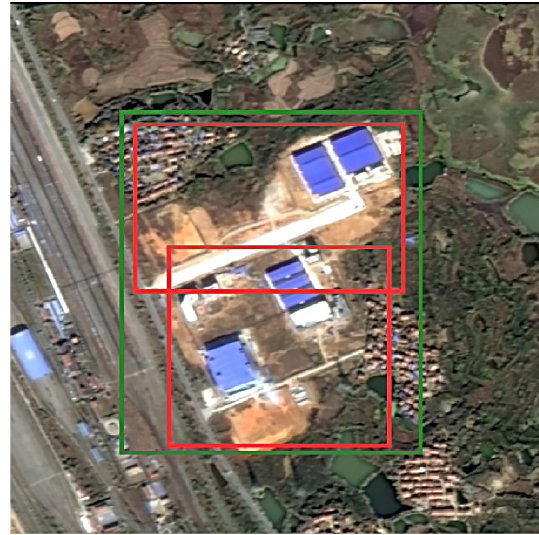
Figure 3. Examples of construction projects.